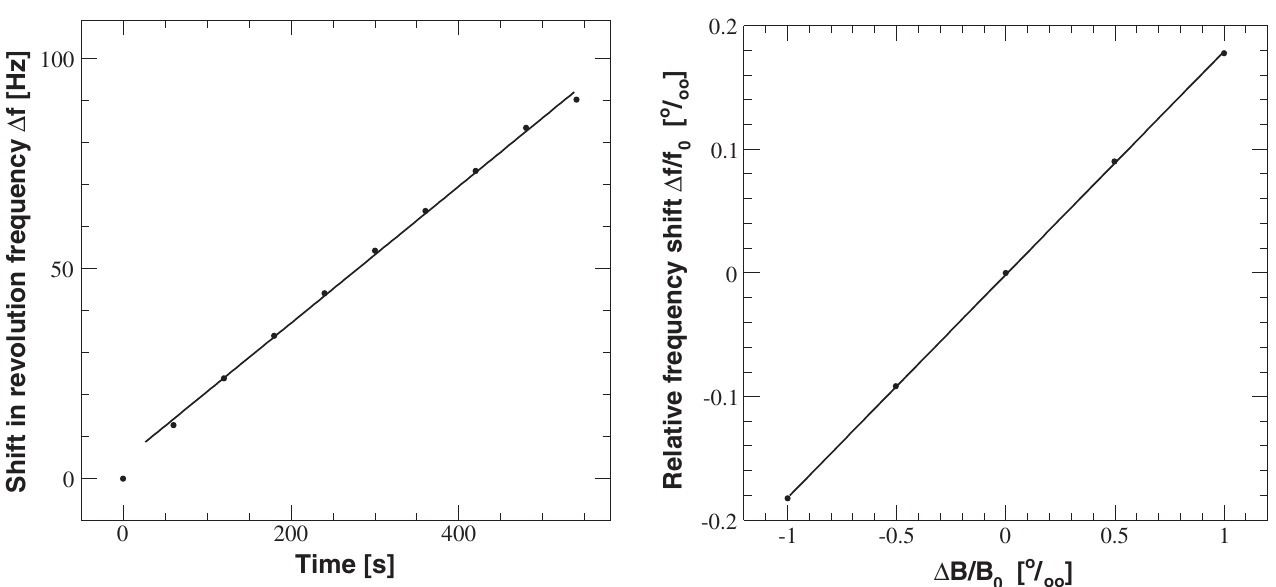
FIG. 5. Typical mean frequency shifts derived from the Schottky power spectra of the type illustrated in Fig. 4 at ten equally spaced intervals of time. These results show a linear increase with time with a slope df=dt (cid:2) (cid:3) 0 : 163 (cid:5) 0 : 003 (cid:4) Hz = s . The first point was omitted from this fit since it was taken too early in the cycle when the COSY magnets have not reached their steady state after the